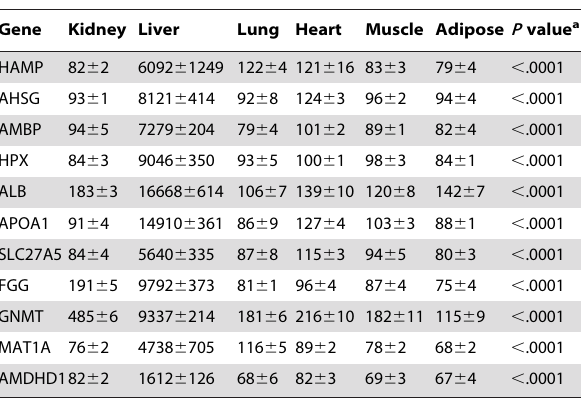
Table 5. Mouse liver-specific gene expression values.